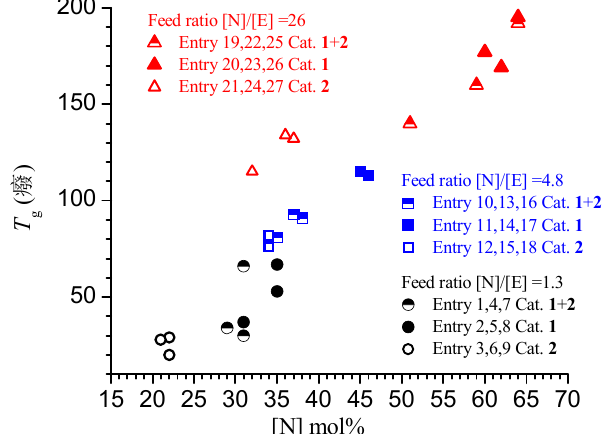
Figure 9. Glass transition temperatures ( T g ) evaluated from the DSC heating thermograms of samples cooled from high temperature of poly(ethylene- co -norbornene) obtained with catalysts 1 (full symbols), 2 (empty symbols) and catalysts 1 + 2 (half full symbols) at [N]/[E] feed ratio of 1.3 (triangles), 4.8 (square) and 26.0 (triangles) and catalysts.